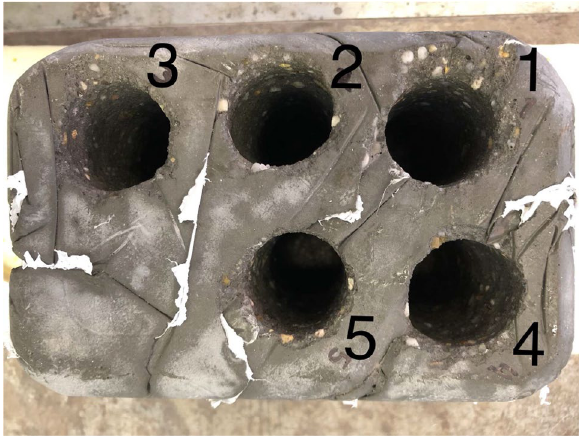
Fig. 9 Five wells drilled in concrete with different parameter configu-